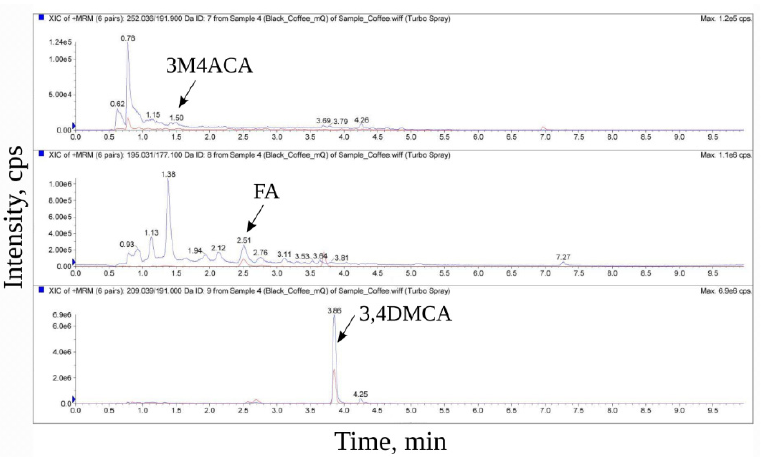
Figure 2. Chromatograms of aqueous extract of black coffee. Only one spectrum of aqueous extract of black coffee is shown in the figure. The spectra of the samples of other extracts are given in the Supplementary Materials in Figure S1. Two MRM transitions (qualifier and quantification transition peak) are shown for each compound. The horizontal axis shows the retention time (RT) of the compounds starting from 0 to 9.5 min with 0.5 min step, and the vertical axis shows the signal intensity. In order to focus separately on the most and least intense “peaks” and “peaks” of average intensity, three different scales of these “peaks” of the same spectrum are shown in the figure; the scaling range is reflected on the vertical axis.